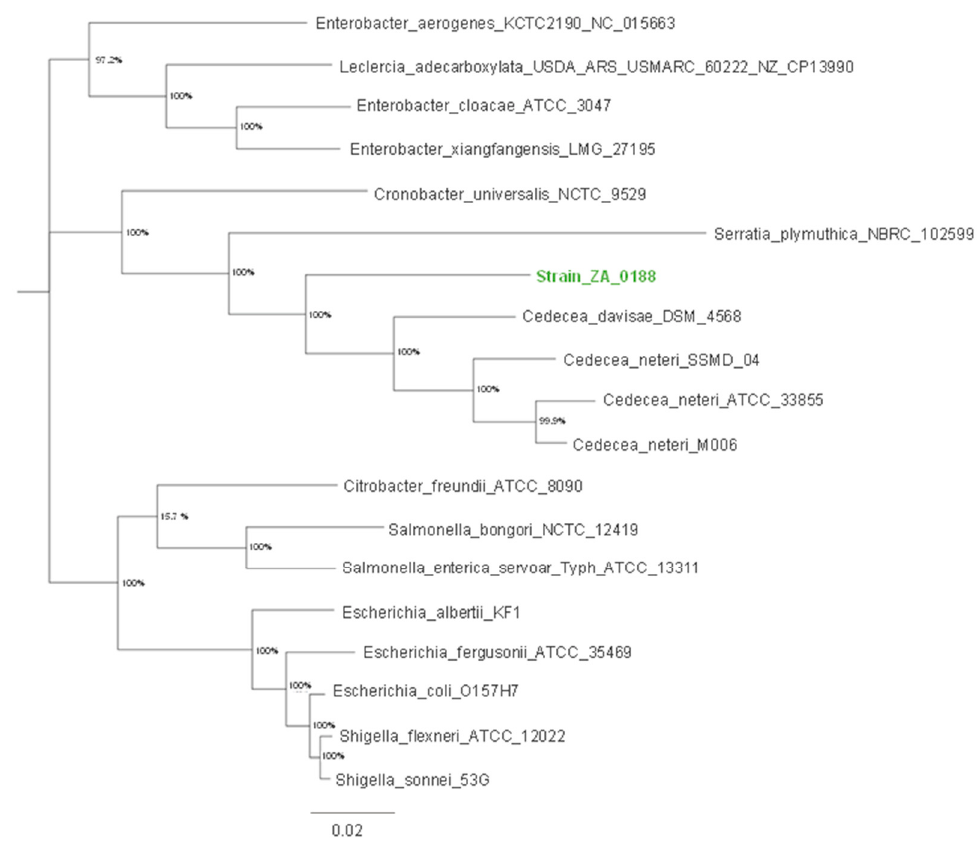
Figure 1. Dendrogram generated using the PhyloSift software pipeline by the neighbour-joining method. Strain ZA_0188 T forms a robust clade with Cedecea and Serratia species with 100% bootstrap support. Bootstrap values are shown at each node and were determined from 1000 repetitions. Scale bar is equal to 0.02 substitutions/nucleotides position.